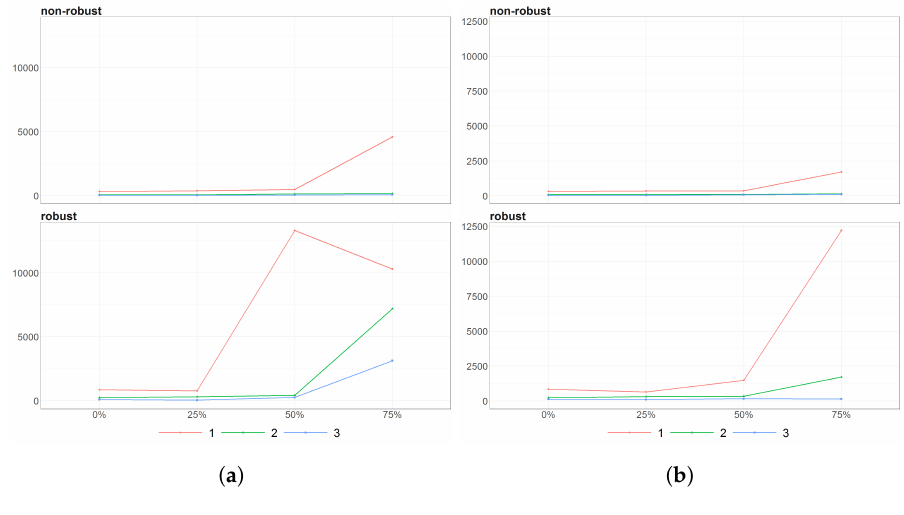
Figure 18. The eigenvalues of Deaths counts obtained using PPCA for Females ( a ) and Males ( b ) over diferent cases of missing entries (x axis). Colours of lines corresponds to different eigenvalues, first (light brown), second (dark blue) and third (dark brown) highest. Every subfigure is divided into two subplots corresponding to robust estimation of standard deviations (upper plot) and sample one (bottom